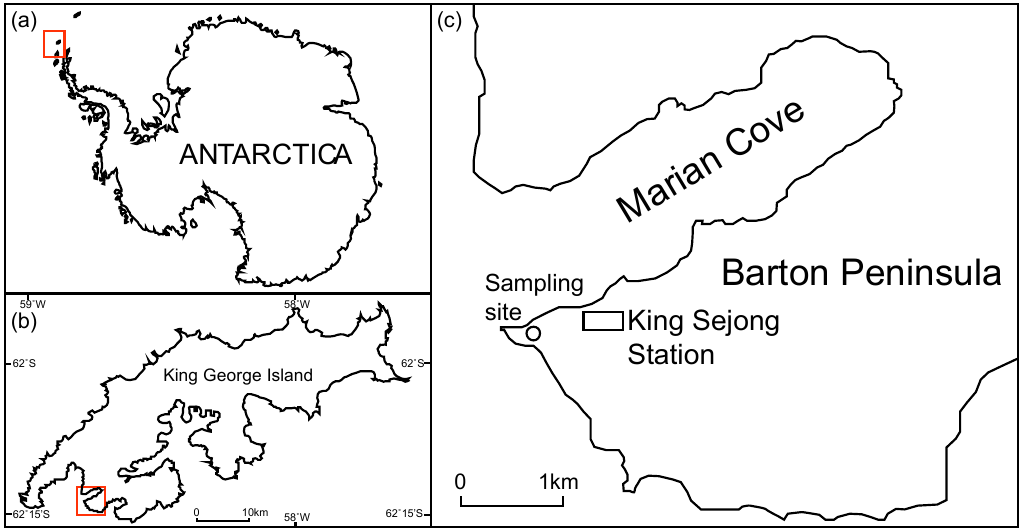
Figure 1. Study area: ( a ) the location of King George Island (red square), ( b ) the location of Marian Cove (red square), and ( c ) the sampling site (circle).